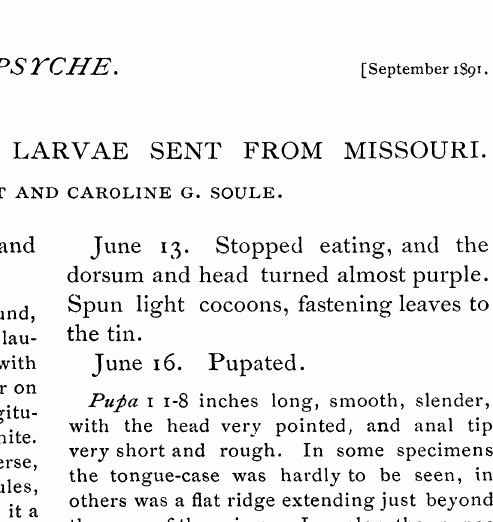
laterally, and with the venter red-brown, with two longitudinal stripes of dark brown which included the base of props and feet. The body was thickly granulated with white, yellower on the sides. Feet and props brown, barred with darker brown. Caudal horn long, slender, straight, sharp, rough, bright yellow at sides of base, blue-black elsewhere. Anal shield with a faint yellow tip. Spiracles deep blue-black, with a white dot in the black at top and bottom; a pale blue ring encircled the whole. No obliques. June 9, 4tk moult.--Like the third, except in size. Length, ing in